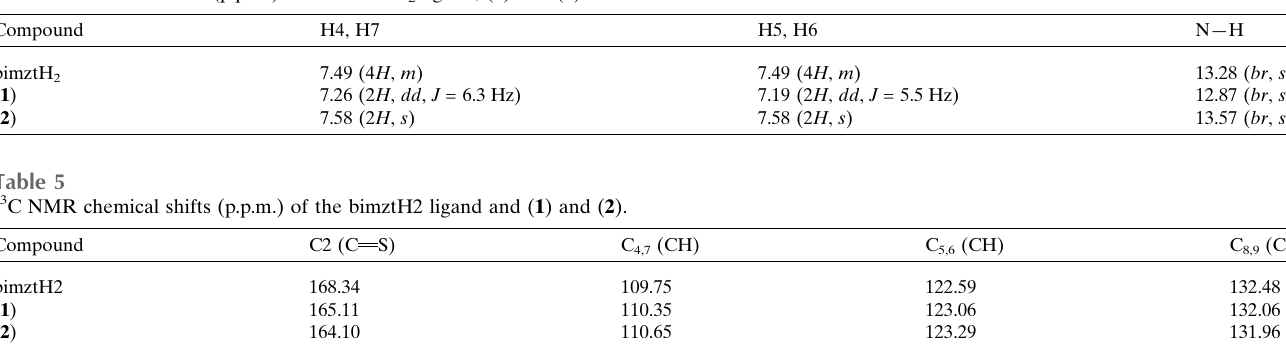
2 ligand, ( 1 ) and ( 2 ).